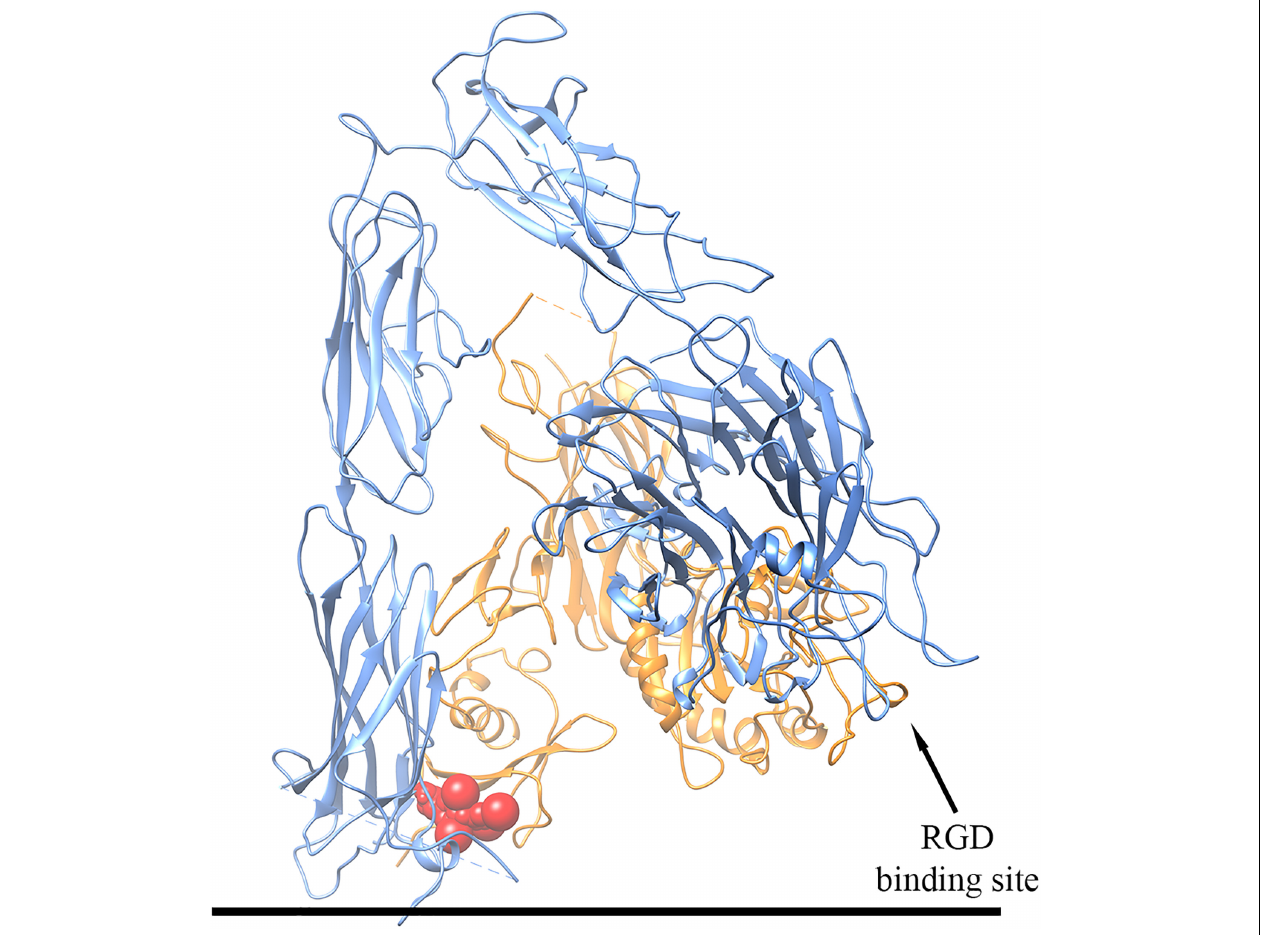
FIGURE 10 | Schematic representation of the three-dimensional structure of the putative complex between T 4 and the α v β 3 integrin obtained by docking simulations. The α v subunit is colored in blue, the β 3 subunit in orange, and T 4 in red. For details, see